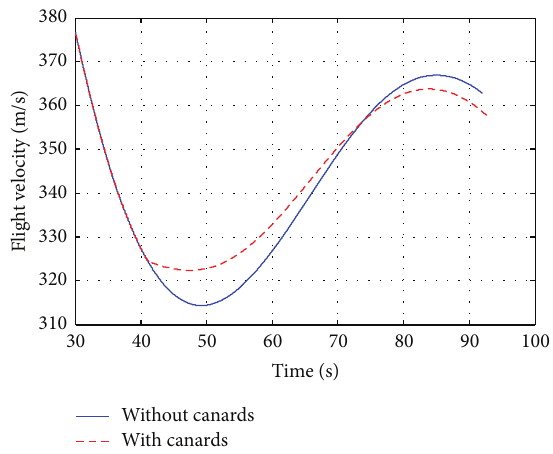
Figure 14: Body roll rate versus time.